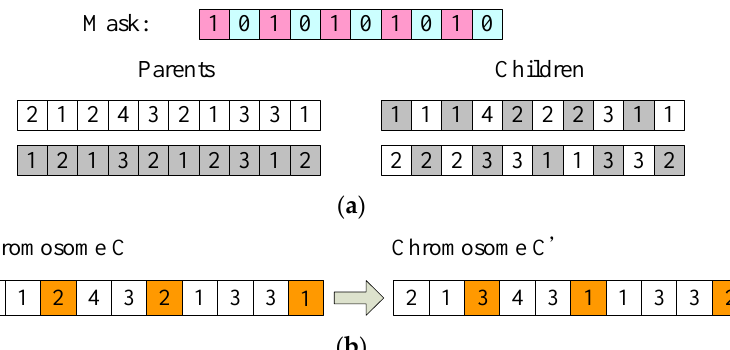
Figure 3. Genetic operators. ( a ) Crossover operation with mask. ( b ) Mutation operation (colored box numbers show the mutation of chromosome C to obtain chromosome C ’ ).